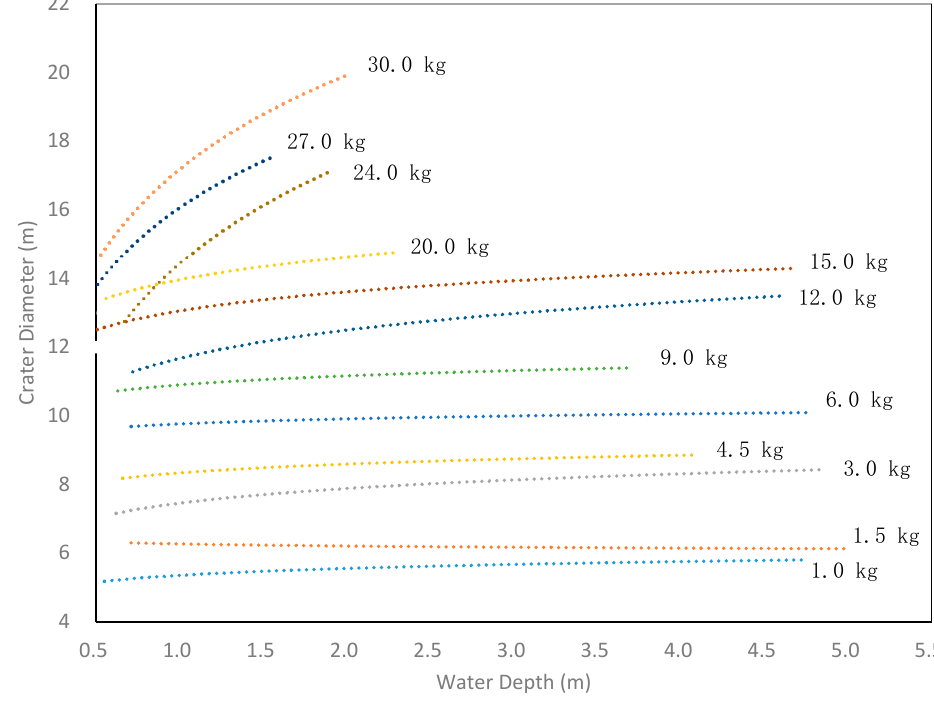
Figure 7. Relationship between measured blasting crater diameter and water depth below ice.